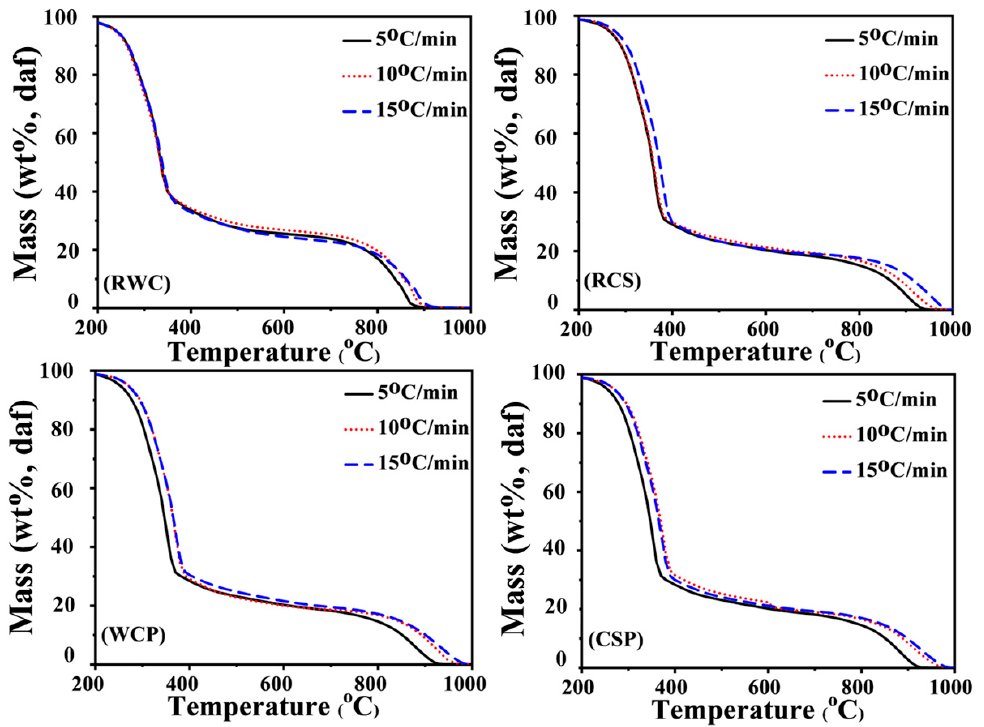
Figure 1. TGA curves of RWC, WCP, RCS, and CSP at heating rates of 5, 10, and 15 °C min − 1 .